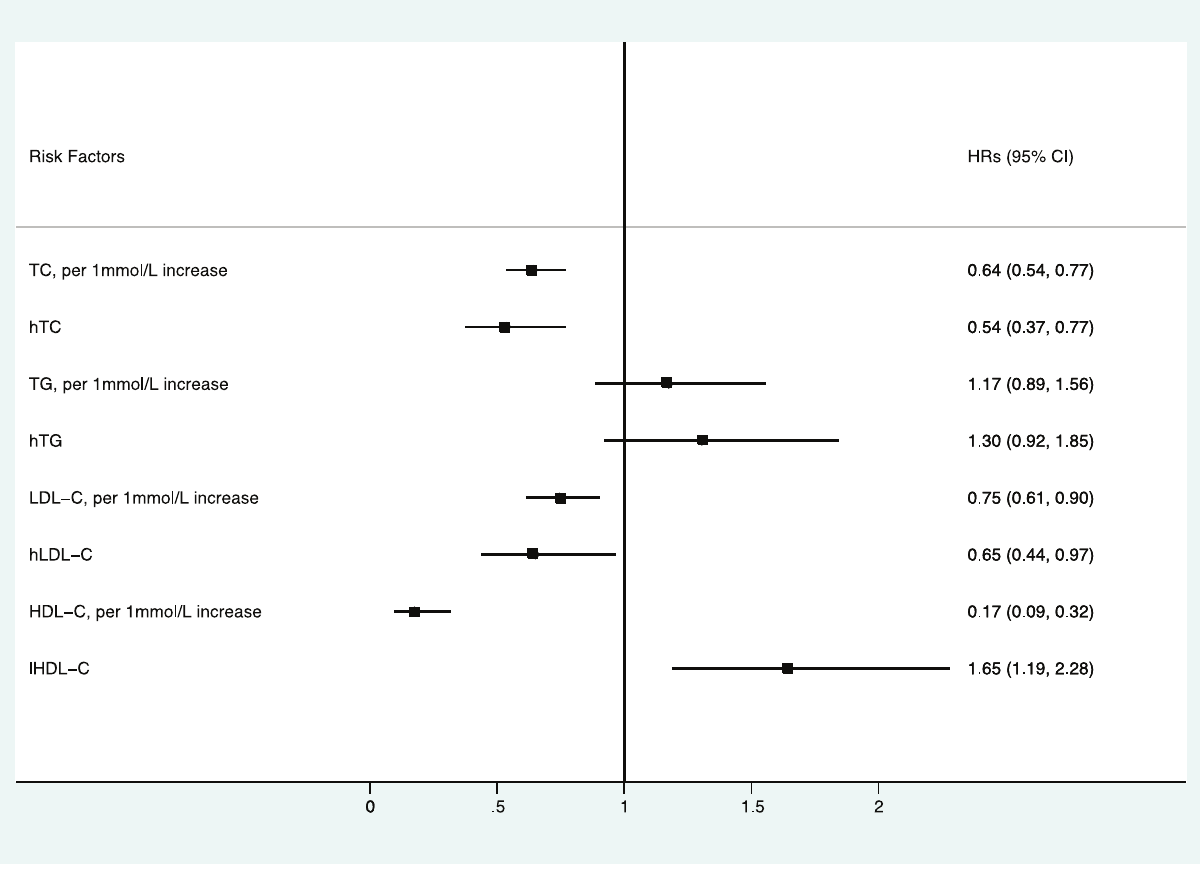
Figure 1. Hazard ratios of plasma lipids and dyslipidemia from stratified Cox regression models. Multifactor adjustment was for obesity, smoke, hypertension, and diabetes. Black squares represent the hazard ratios, and error bars indicate the 95% confidence intervals